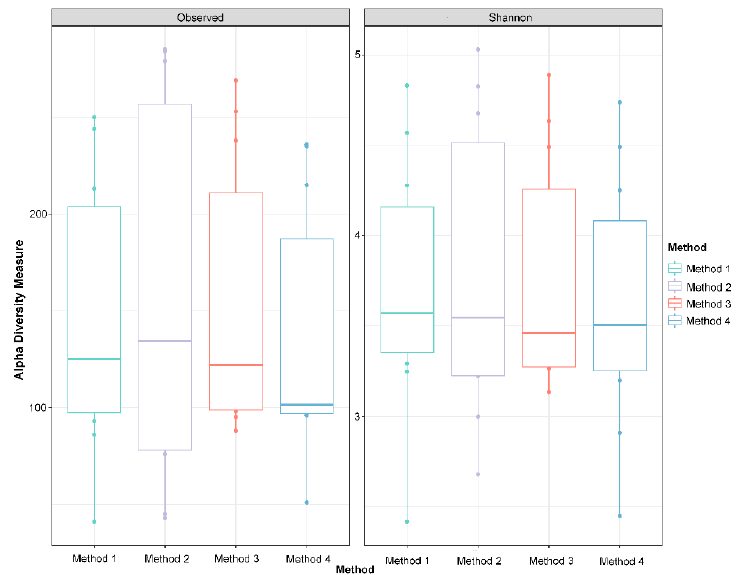
Figure 5. Alpha diversity indices do not differ between DNA extraction methods. Observed ASVs and Shannon’s Index, two metrics of alpha diversity, are visualized with boxplots where the middle bar represents the median, the boxes represent the interquartile range, and the whiskers extend to 1.58 times the interquartile range. There are no significant differences between DNA extraction methods in either diversity metric ( p > 0.05, Kruskal–Wallis test).